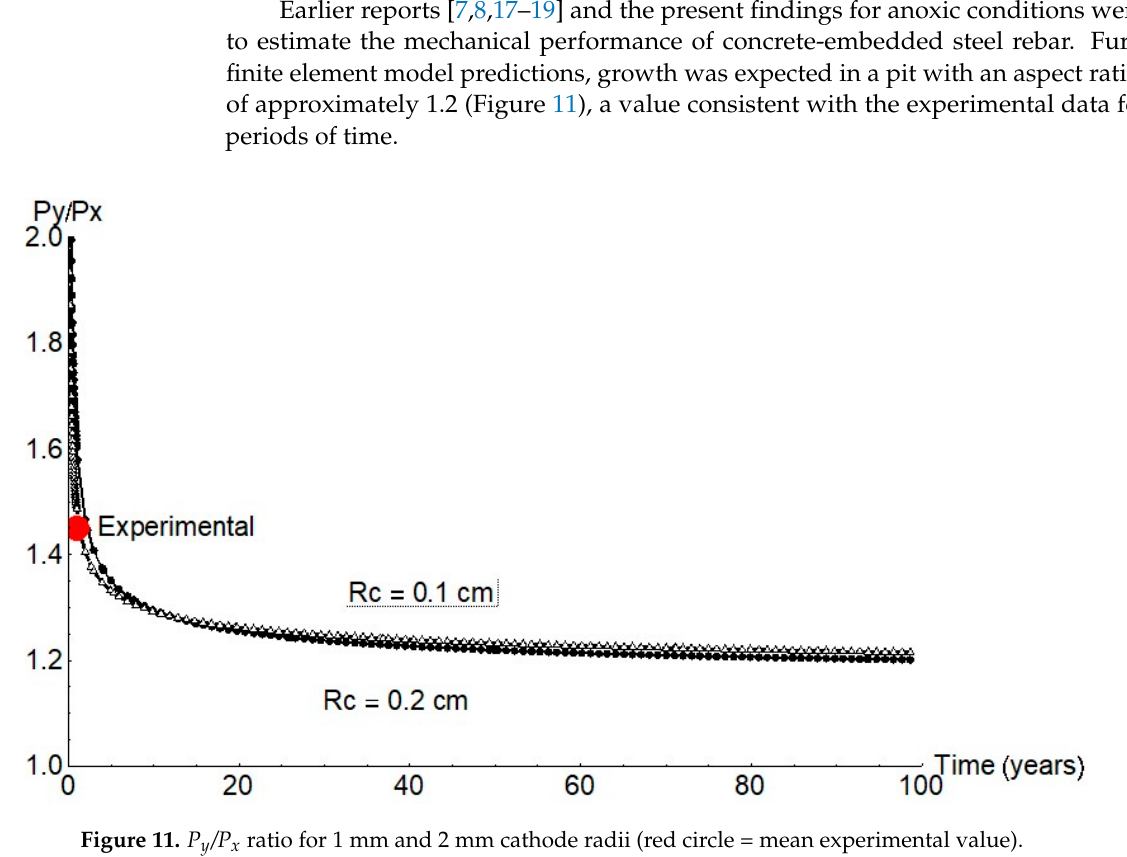
Figure 10. Variation in pitting factor over time for the geometries studied; right, variation for a cathode area with radius = 0.1 cm to 0.2 cm.